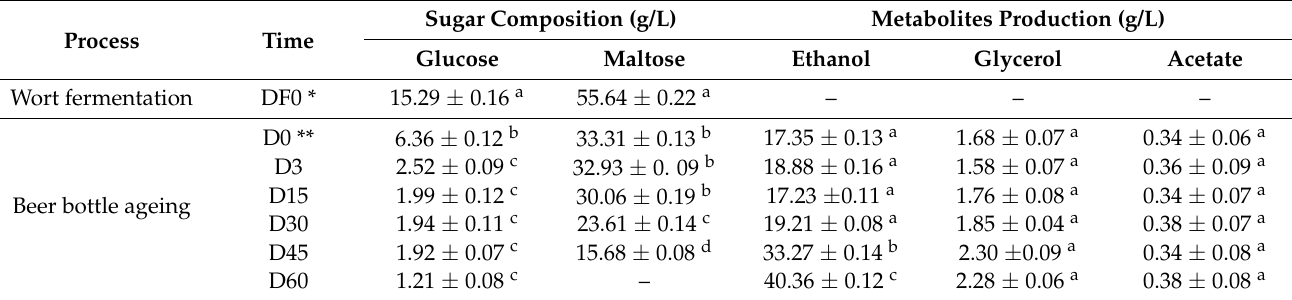
Table 2. Sugars (glucose and maltose) and metabolites (ethanol, glycerol, and acetate) content during malt extract fermentation and storage at 20 ◦ C for 3, 15, 30, 45, and 60 days. For each storage time point, means in a column followed by the same letter are not significantly different ( p ≥